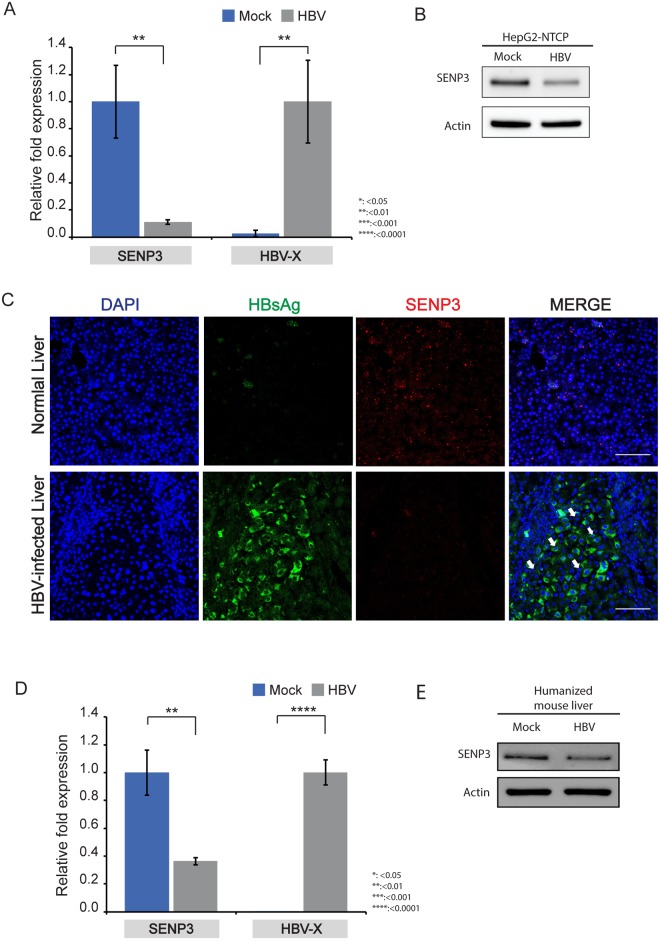
SENP3 is downregulated in HBV-infected hepatocytes.(A) RT-qPCR measurement of SENP3 mRNA level in HepG2-NTCP cells on Day 7 after HBV infection and mock infection. HBV transcripts were amplified by the primer pair HBV-X to indicate the presence of HBV in the cells. Beta-actin was used as internal control; the data were expressed as mean±SD (n = 3). The statistical significance was assessed by Students’ unpaired t-test. (B) Immunoblotting SENP3 steady-state level in HepG2-NTCP cells on Day 7 after HBV infection and mock infection. (C) Representative immunofluorescence (IF) images of SENP3 protein levels in tissue sections of normal and HBV-infected livers. The white arrow indicates SENP3 signal. Scale bar indicates 100 μm. (D) RT-qPCR measurement of SENP3 mRNA level (n = 3) in HBV-infected and uninfected livers from a humanized mouse model (A2/NSGNRF-FAH-huHSC/Hep). Beta-actin was used as internal control; the data were expressed as mean±SD (n = 3). The statistical significance was assessed by Students’ unpaired t-test. (E) Immunoblotting of SENP3 translational level in HBV-infected and uninfected livers from a humanized mouse model (A2/NSGNRF-FAH-huHSC/Hep).